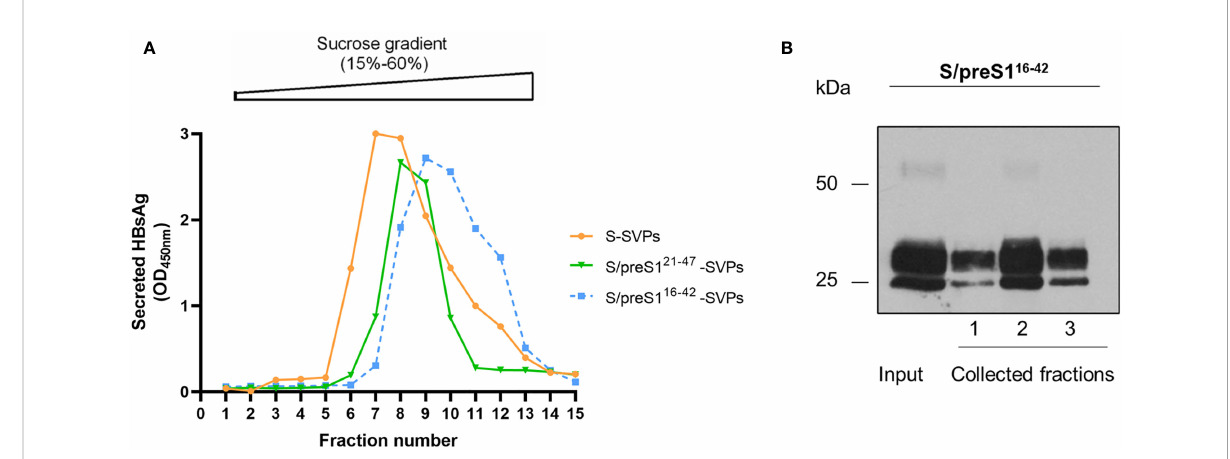
FIGURE 4 Assembly and puri fi cation of the novel S/preS1 16-42 antigen. (A) HEK293T cells were transfected with pCi plasmids encoding the S/preS1 21-47 , S/ preS1 16-42 , and S antigens. Cell supernatants were collected between days 4 and 10 post-transfection, 20-fold concentrated and subjected to ultracentrifugation onto a 15-60% step sucrose gradient. Collected fractions were diluted 1000-fold and analyzed for their HBsAg content by ELISA. Results are shown as optical density values measured at 450 nm. (B) The S/preS1 16-42 antigen was further puri fi ed using the CaptoCore 400 resin, by gravitational fl ow. A representative image con fi rming the presence of the antigen in input sample and collected fractions, as determined by western blot using anti-preS1 antibodies is shown